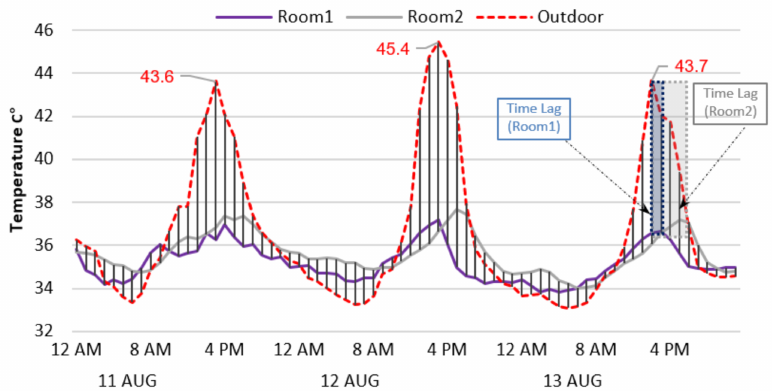
Figure 16. Hourly indoor and outdoor air temperature on 11, 12 & 13 August